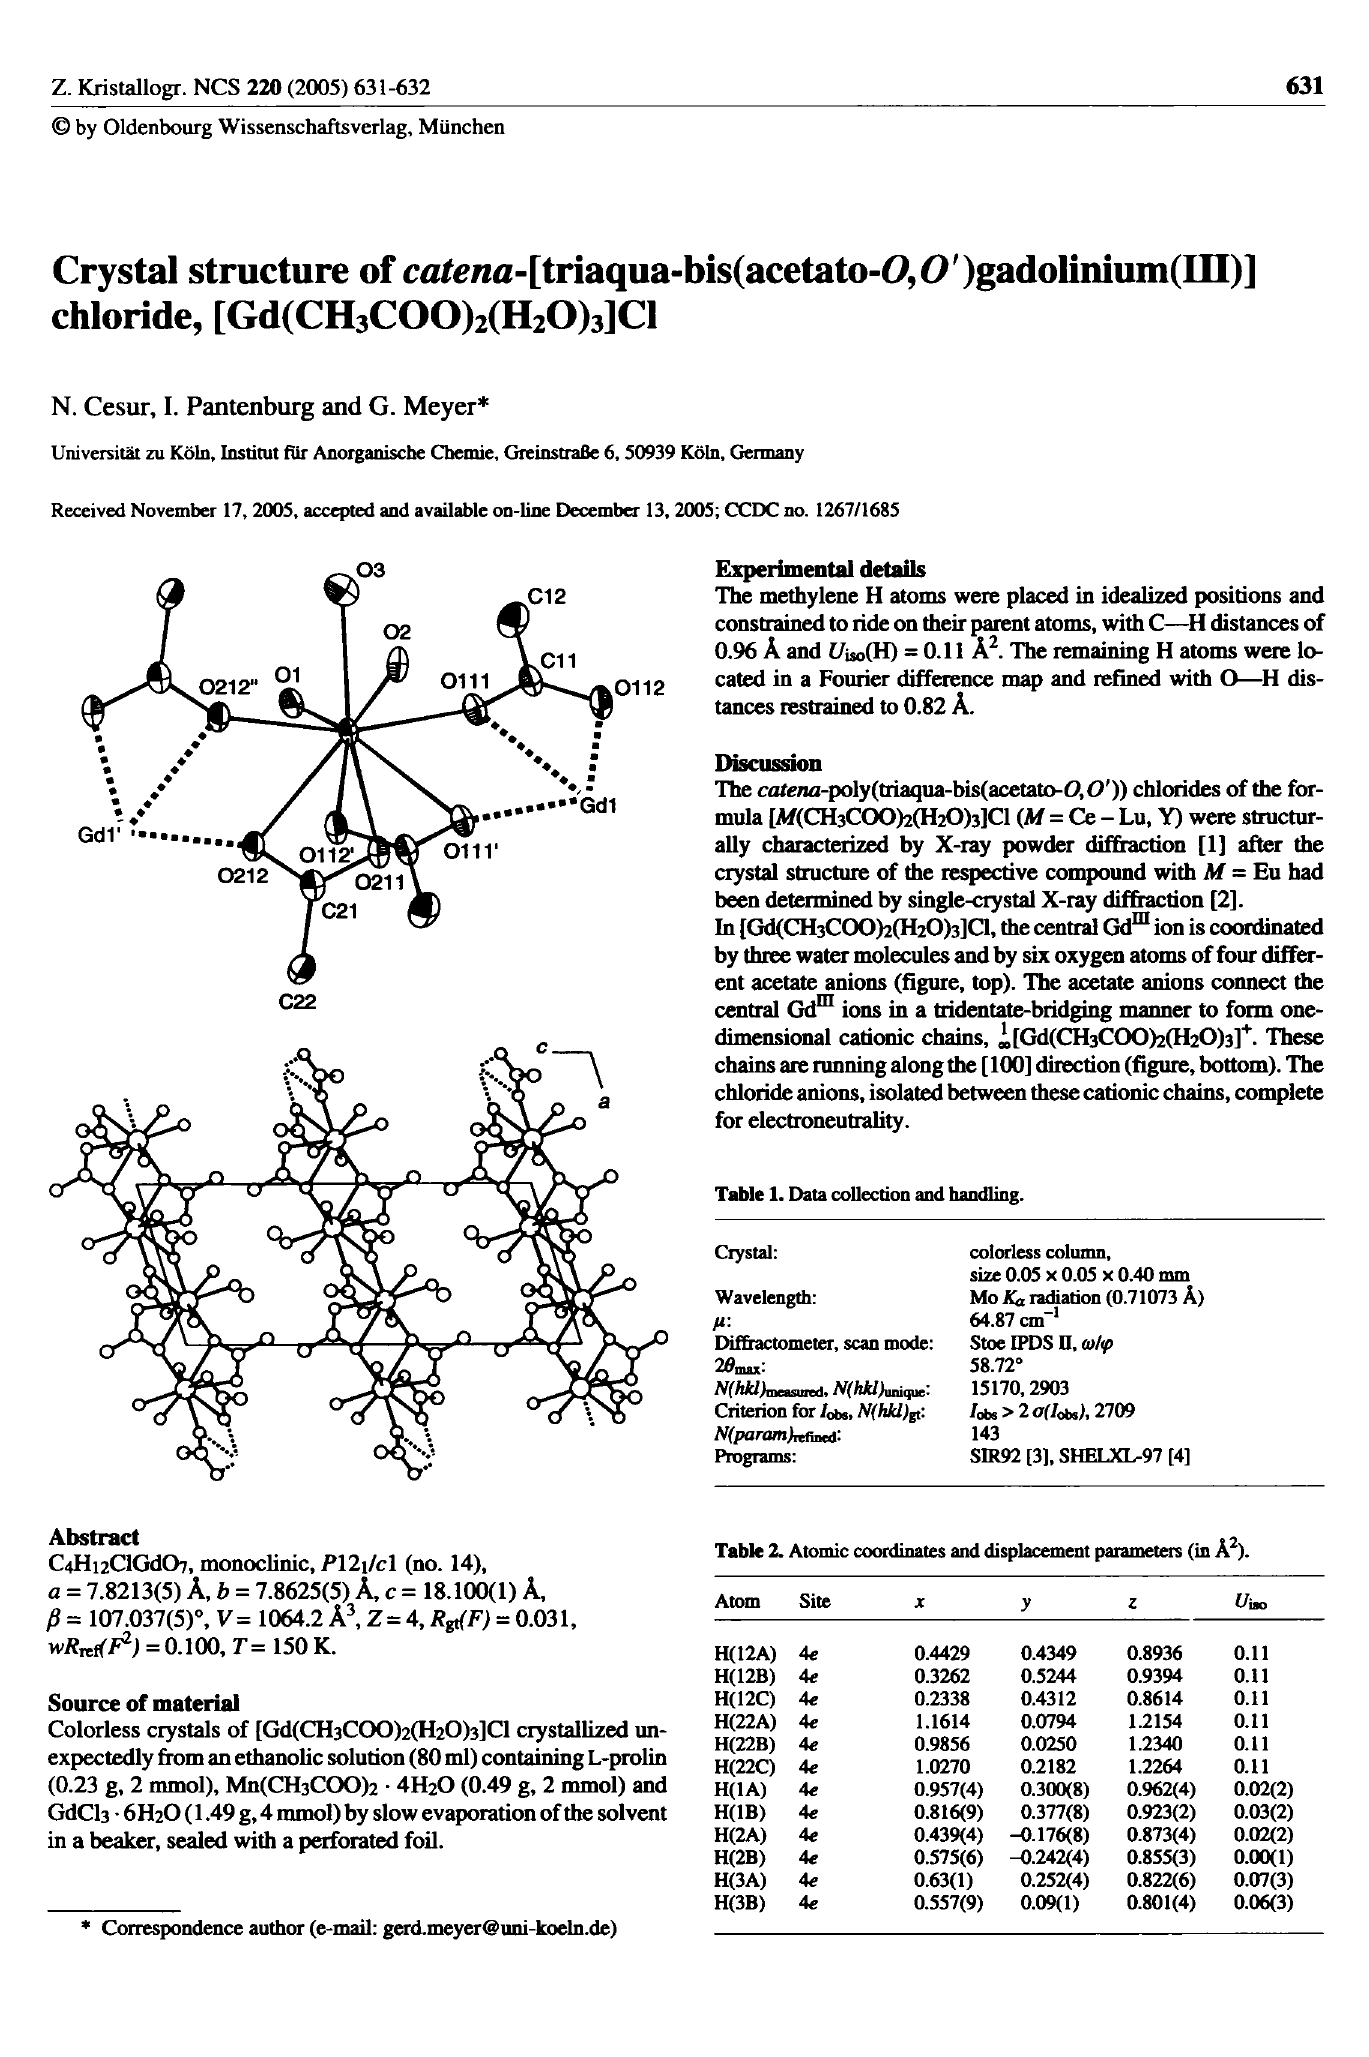
Table 2. Atomic coordinates and displacement parameters (in Ä 2